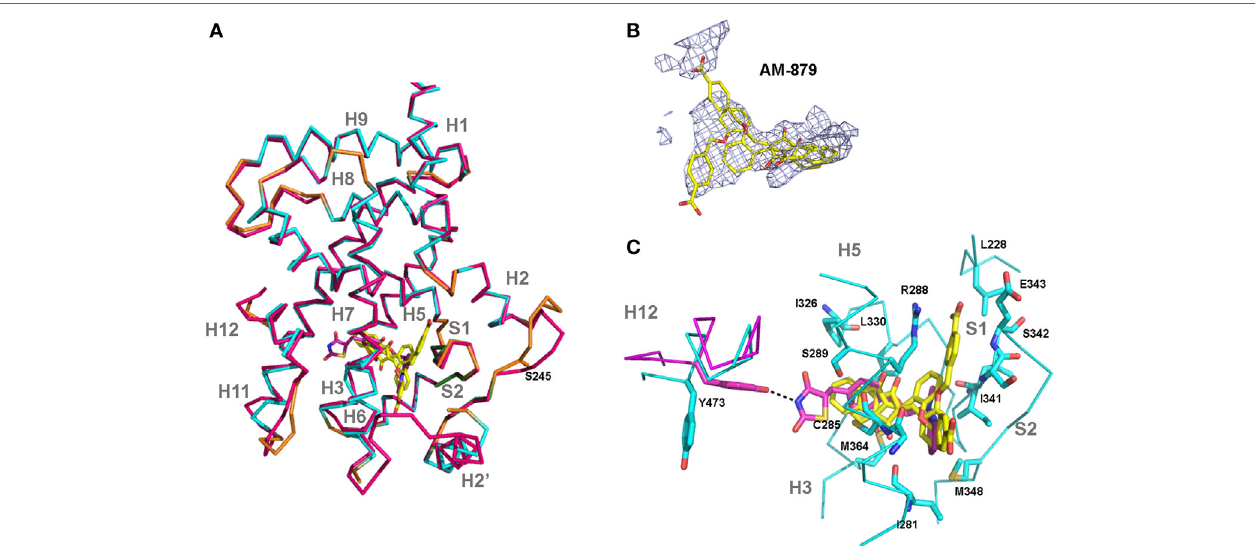
FigUre 7 | Crystal structure of peroxisome proliferator-activated receptor gamma (PPAR γ )-ligand-binding domain (LBD) in complex with AM-879. (a) Superimposition of the co-crystal structure of PPAR γ -LBD bound to AM-879 on the structure with Rosiglitazone (Rosi; PDB code 2PRG). Carbon atoms are shown in cyan (alpha helix), green (beta-sheet), and orange (loop) in the AM-879 complex, and in pink, in the Rosi structure. The ligands are shown in stick representation with carbon colored yellow or pink, respectively, for AM-879 and Rosi and the serine S273, site of phosphorylation by cyclin-dependent kinase 5 (CDK5), is shown as orange sticks. (B) AM-879 in the Polder map contoured at 3.0 σ . (c) PPAR γ residues (shown as blue sticks) in contact with AM-879. Highlight for Tyrosine 473 (pink sticks) important for the Rosi binding and agonism. Residues number corresponds to PPAR γ 1